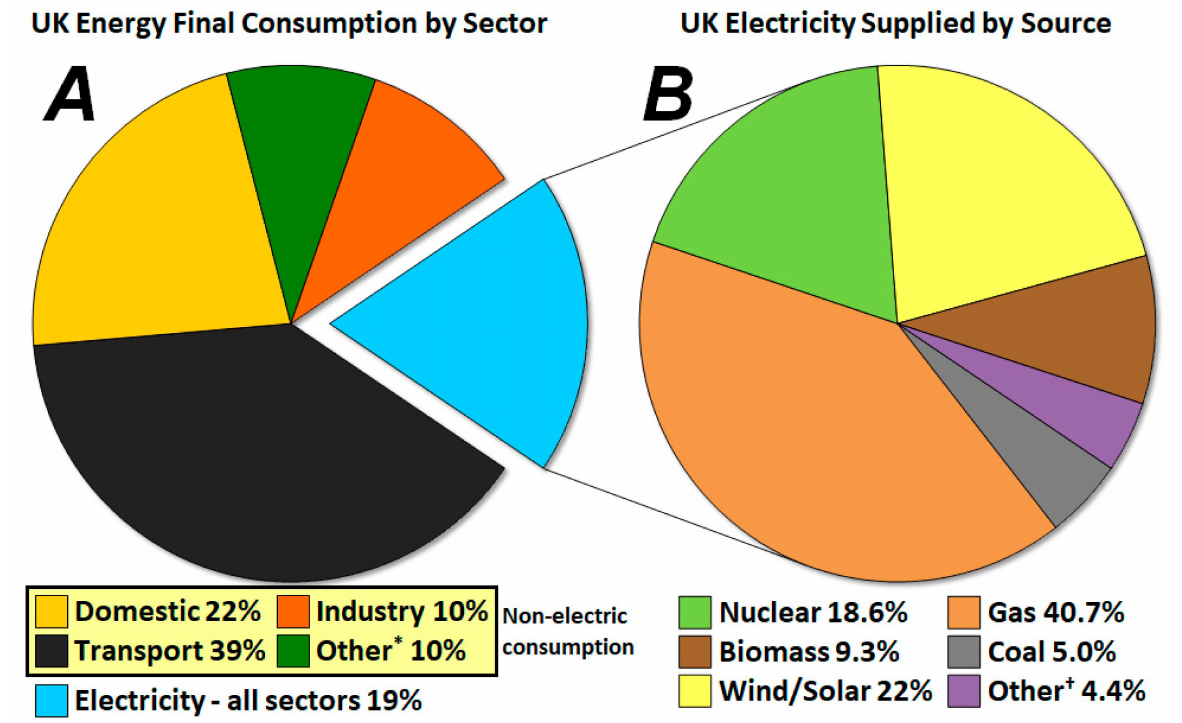
Figure 1. ( A ) UK proportional final energy consumption by sector in 2018. Domestic, industry, transport and other consumption only include non-electric energy consumption; the blue segment comprises the electricity use by all sectors ([16], pp. 11–30; Table 1.1). ( B ) The electricity supply by source in the UK in 2018 ([16], pp. 80–107; Tables 5.6 & 5.1.3). 47% of final energy consumption is petroleum products; 29% is natural gas (not including natural gas used in electricity generation). * “Other” sectors comprise administrative, commercial, agricultural and miscellaneous consumption. † “Other” electricity sources comprise hydroelectric generation and, pumped storage and oil